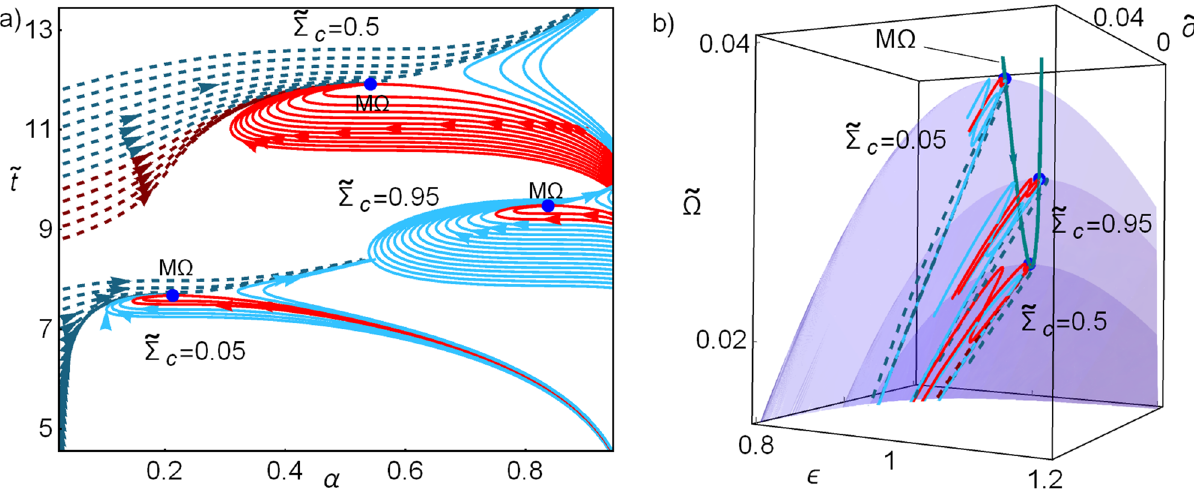
Figure 2. Some representative trajectories given by solving numerically Eqs. (9) and (10). The symmetry (cid:31) c affects the shape of the basin of attraction. In ( a ) three cases are depicted: in the dissipation coefficient 0.05, 0.5, 0.95 (cid:31) c , the symmetric case exhibits the largest stability basin. In ( b ) some trajectories are = { } 3 / 5 . The red curves indicate trajectories inside the basin of mapped into the energetic surface with τ (cid:31) = attraction; dashed (red and blue online) curves denote those trajectories with initial conditions α (cid:31) 1 continuous lines (red and blue) those with initial conditions α →